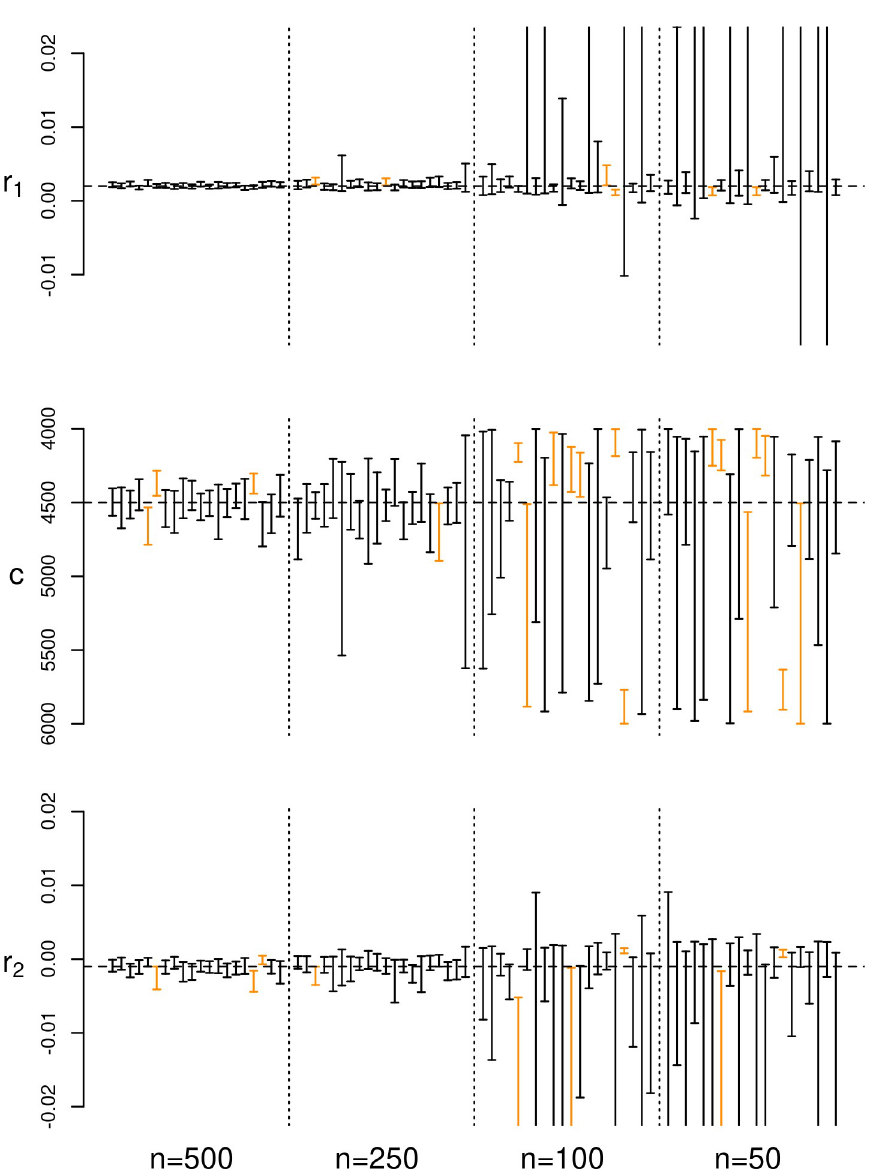
Fig 5. Results of experiment 3b. Error bar represents the estimated 90% HPD interval for each run; cases where the true parameters were not within the interval are displayed in orange. rate between 0.2 and 0.3%. The smaller sample sizes associated with the first growth phase (parameter r in m2 and m3 ) has led to a wider 90% HPD including negative and positive 1 rates, although in both cases, the median growth rate was negative. Both m2 and m3 have identified the change point c in the growth rate between the end of the 8th century and the beginning of the 7th century BCE, with a similar 90% HPD interval between late 9th century and early 6th century BCE. The fitted models (Fig 8) thus indicate a growing density of radio- carbon dates over time, with both m2 and m3 suggesting a possible declining trend during the Final Jomon period, followed by a steep growth starting around the Early Yayoi period.